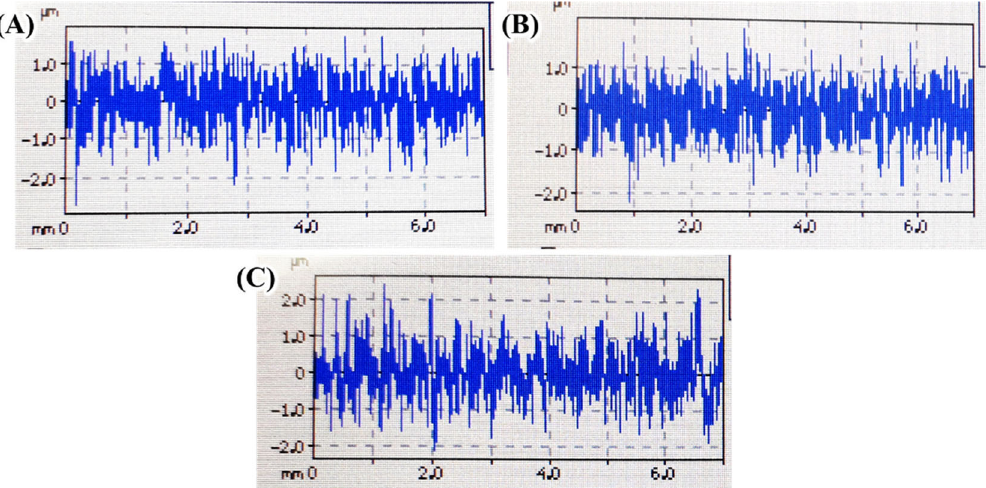
Figure 6.Representativeofsurface roughnesstexture ofuntreated Ti(A),AgcoatedTifrom0.01 mol/LAgNO 3 (B), and Ag coated Ti from 0.1 mol/L AgNO 3 (C) generated from roughness tester. 16